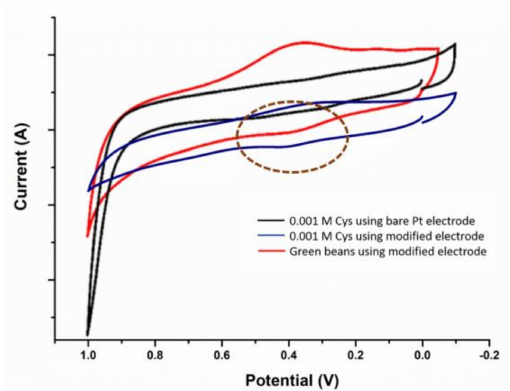
Figure 9. Cyclic voltammogram of extracted sample from green beans using bare Pt electrode and CNOs–Ps / Pt